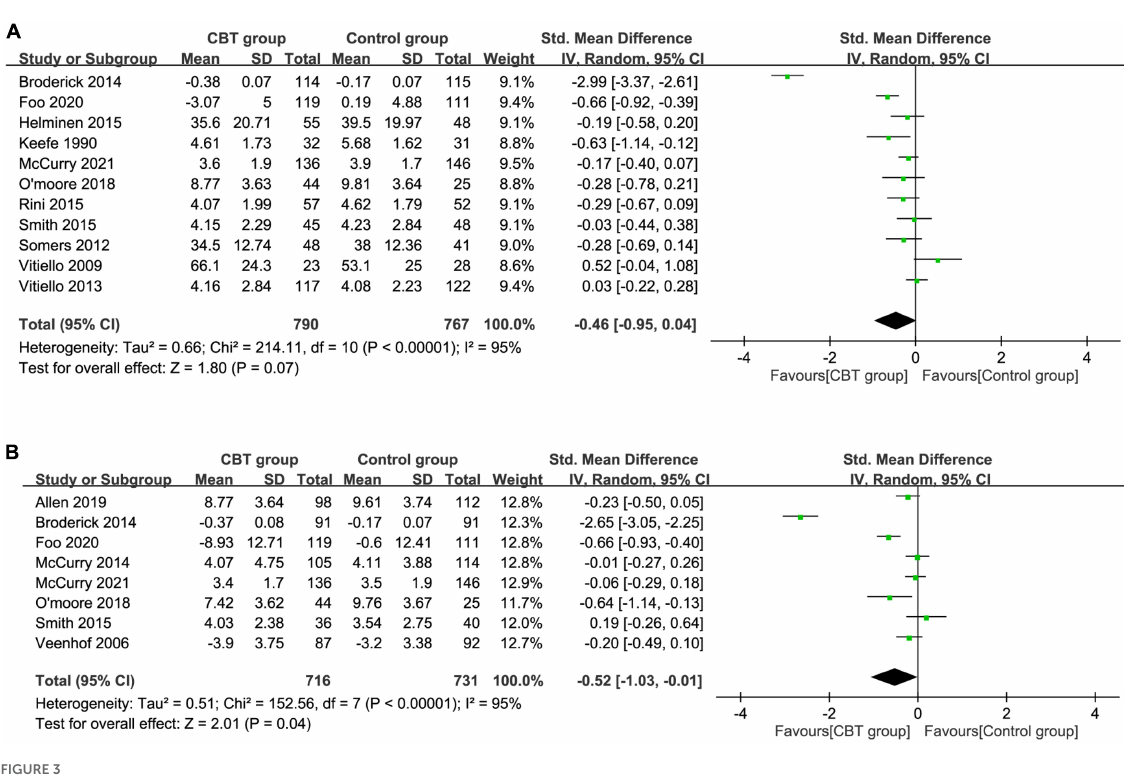
after treatment (SMD = –0.11, 95% CI:-0.25 to 0.02, P = 0.09, I 2 = 20%, five RCTs, 720 patients) ( Supplementary Figure 6 ) (33, 36, 38, 41, 46) and during the follow-up period (SMD =